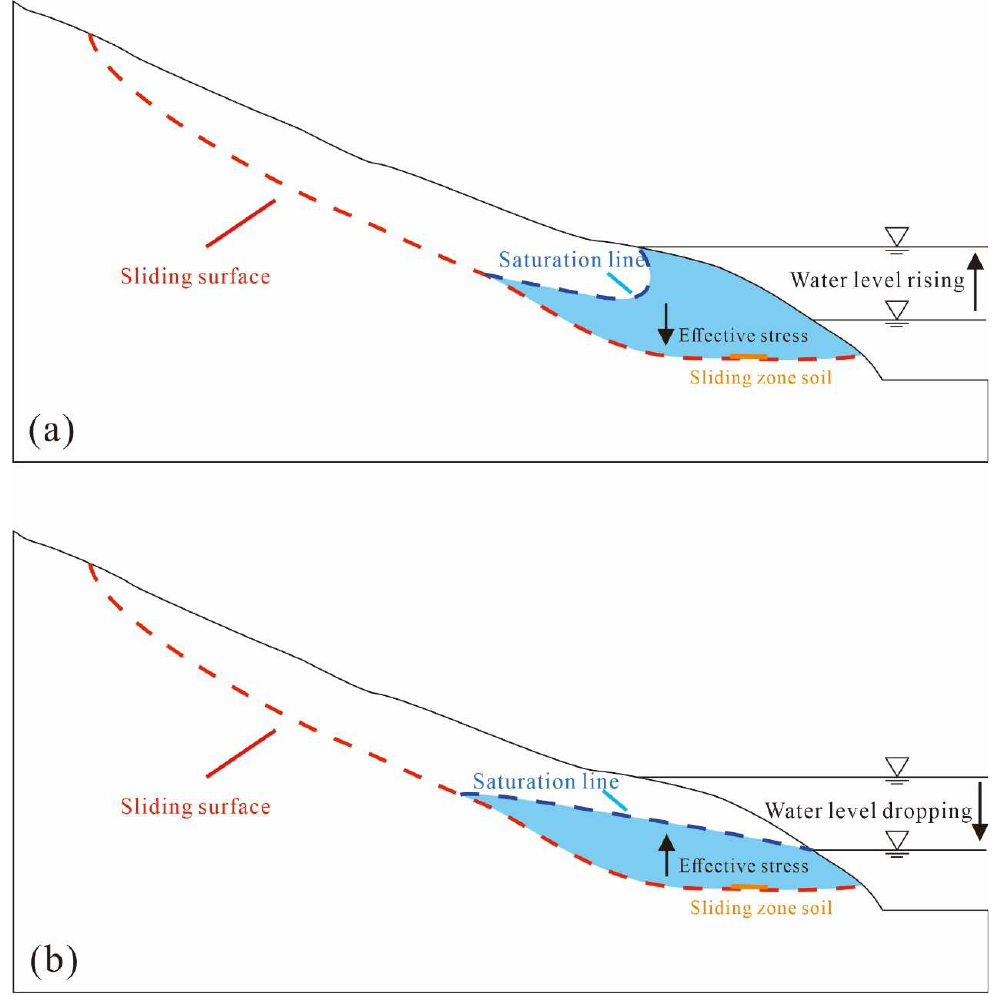
Figure 2. Changes in effective stress in sliding zone soil caused by reservoir water level fluctuations. ( a ) Water level rising and ( b ) water level dropping.